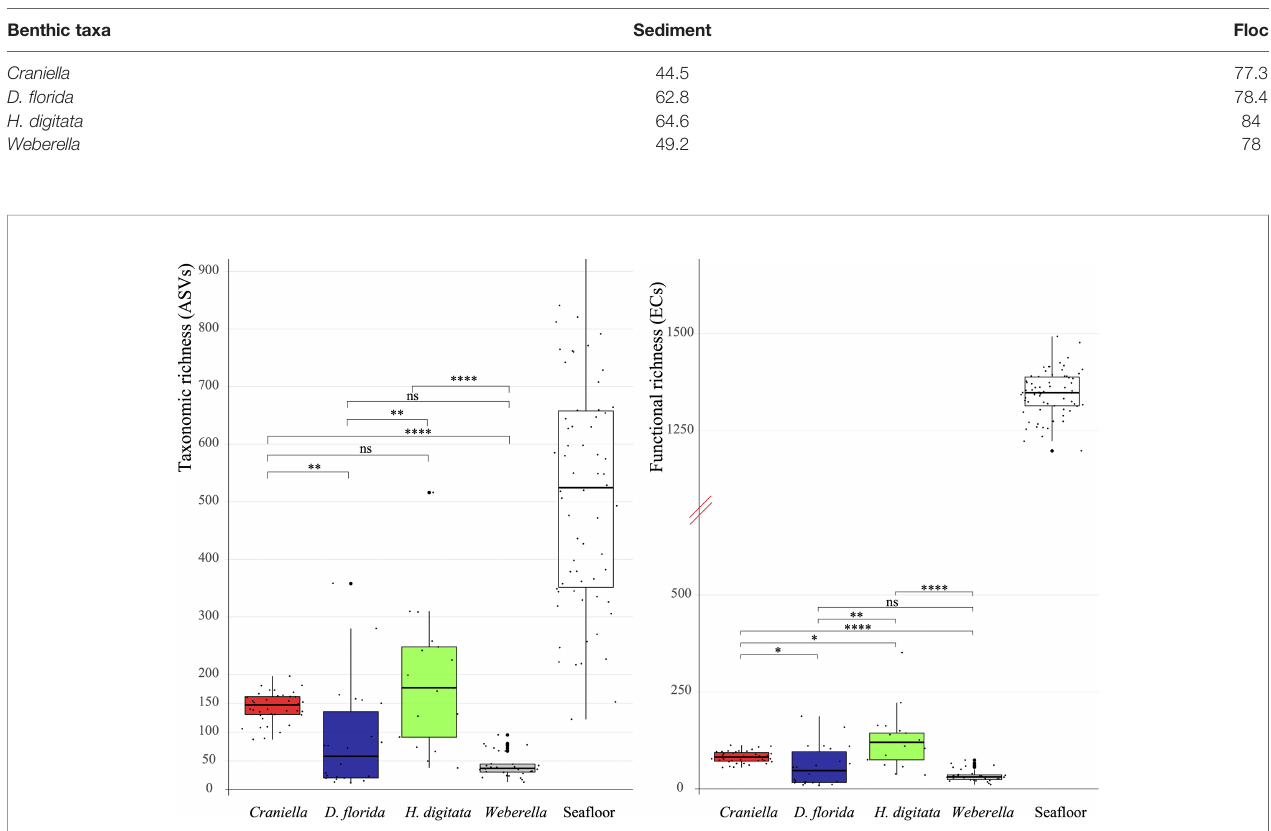
FIGURE 6 | Boxplot of bacterial taxonomic (ASV) and functional (EC) richness per epibenthic taxa and sea fl oor samples (sediment & fl oc) with pairwise Mann-Whitney-Wilcoxonresults. The y axis of the functional richness has been truncated to better visualise values between taxa and sea fl oor samples. Signi fi cant differences between taxa were tested with analyses ofvariance andare displayed on top of the boxplots. ns= non-signi fi cant, * = 0.05 > adj. p.value ≥ 0.01, ** = 0.01 > adj.p.value ≥ 1e -3 , *** = 1e -3 > adj. p.value ≥ 1e -4 , **** = 1e -4 > adj. p.value ≥ 1e -5 .